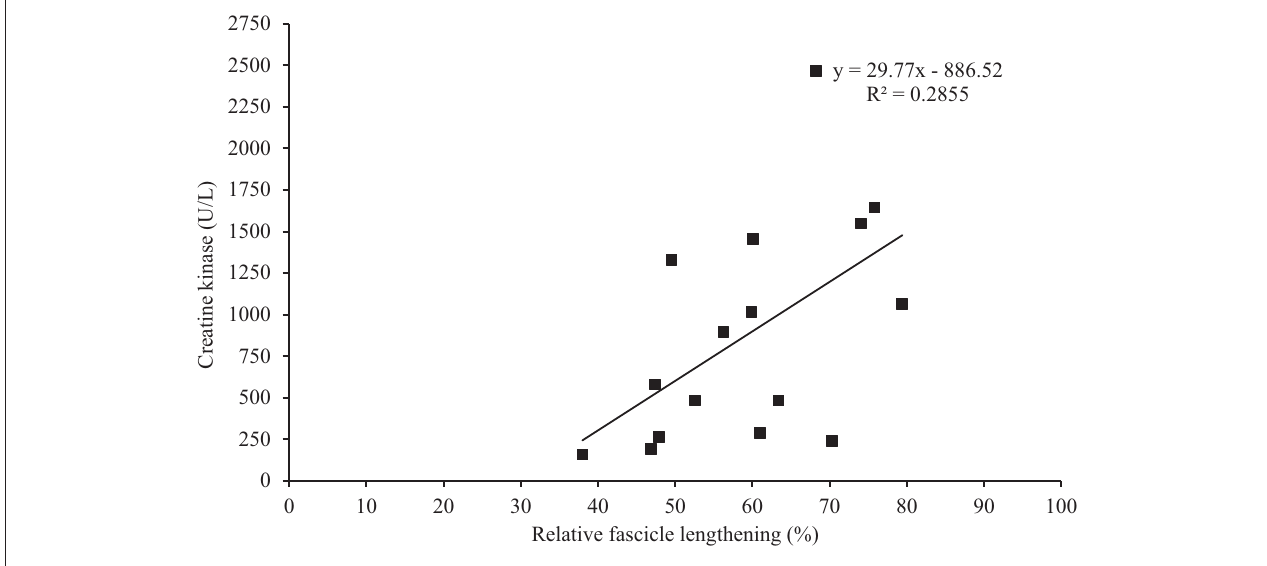
FIGURE 4 | Correlation between creatine kinase (from pre to peak creatine kinase over the 168h ( 1 CK peak )) and relative change in fascicle